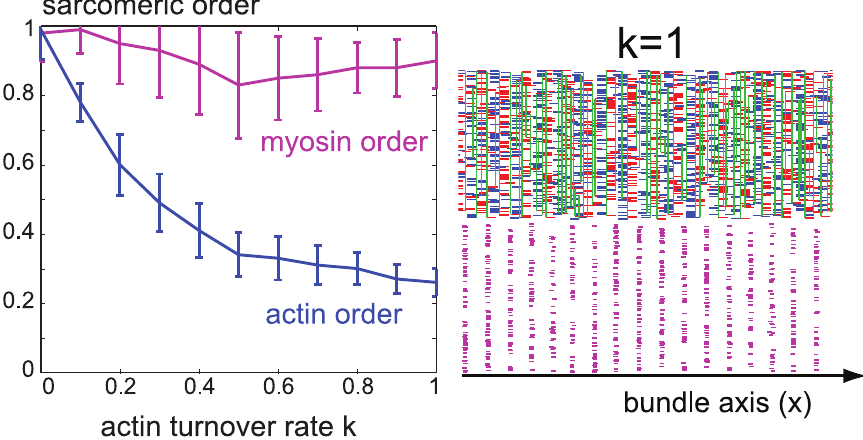
Figure 5. Myosin order despite actin turnover. We devised a minimal model of actin filament turnover, see main text. For simulations as in figure 3, but with actin turnover, the sarcomeric order parameter was found to decrease as a function of actin filament turnover rate (blue curve) as actin turnover impedes the formation of large actin clusters (blue, mean + s.e., n ~ 100 ). Surprisingly, an analogously defined order parameter for myosin positions attains significant values even for considerable actin turnover rates. A simulation snap-shot at t ~ 50 is shown to the right for actin turnover rate k ~ 1 (in units of v 0 = L 0 ).